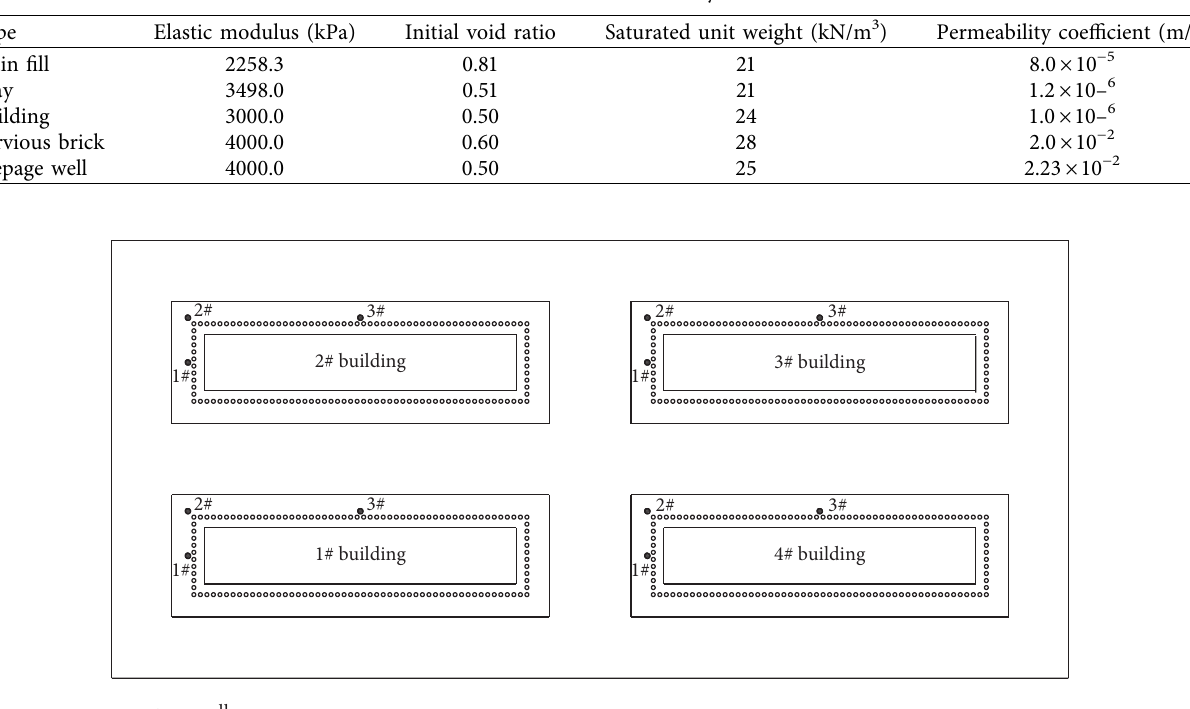
Figure 11: Mesh model of building without seepage well. Table 5: Parameters of soil